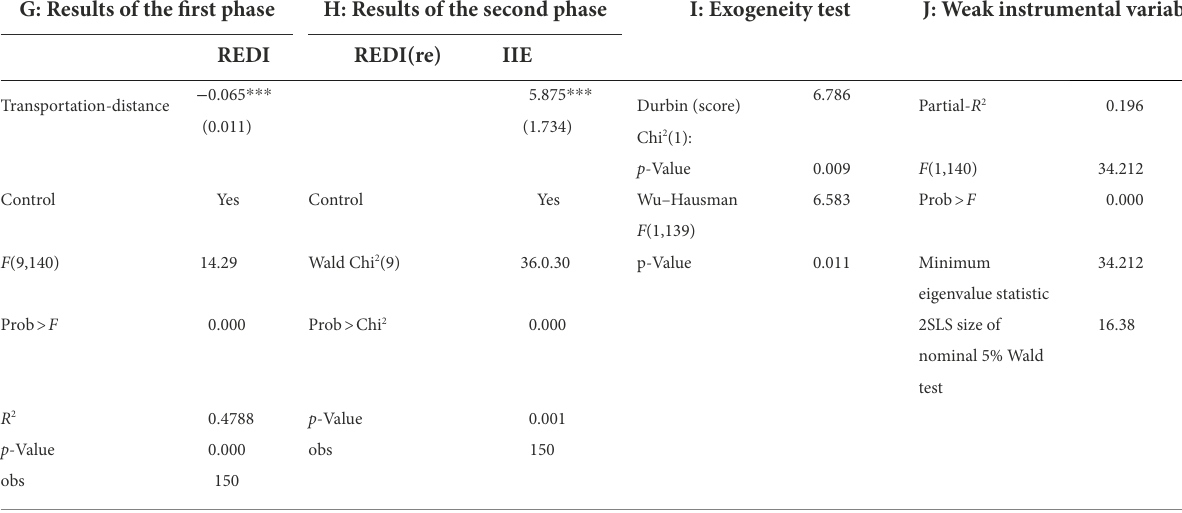
TABLE 6 Endogeneity test: digital economy and